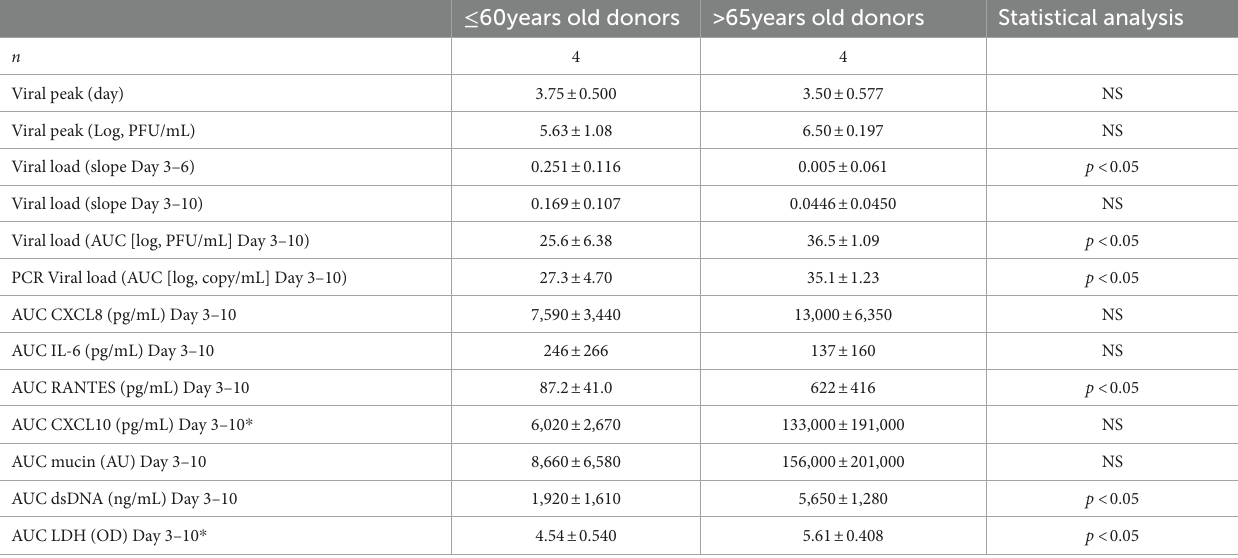
TABLE 2 Comparison of viral infection parameters and biomarker levels between younger (≤60 years old) and elderly (>65 years old)